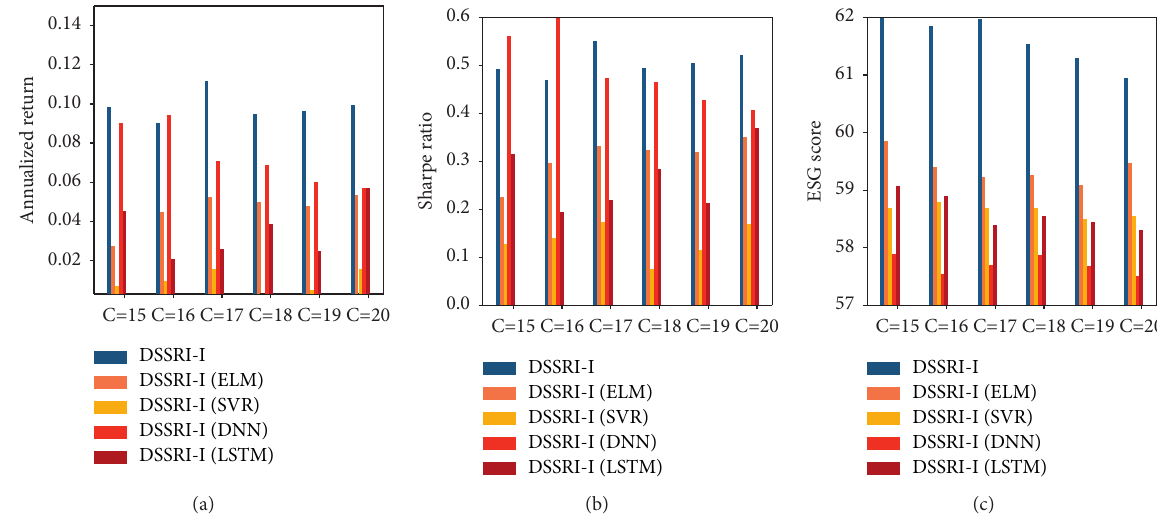
Figure 4: Performance of the DSSRI-I model and the DSSRI-I (based on other machine learning models) at different portfolio cardinalities.